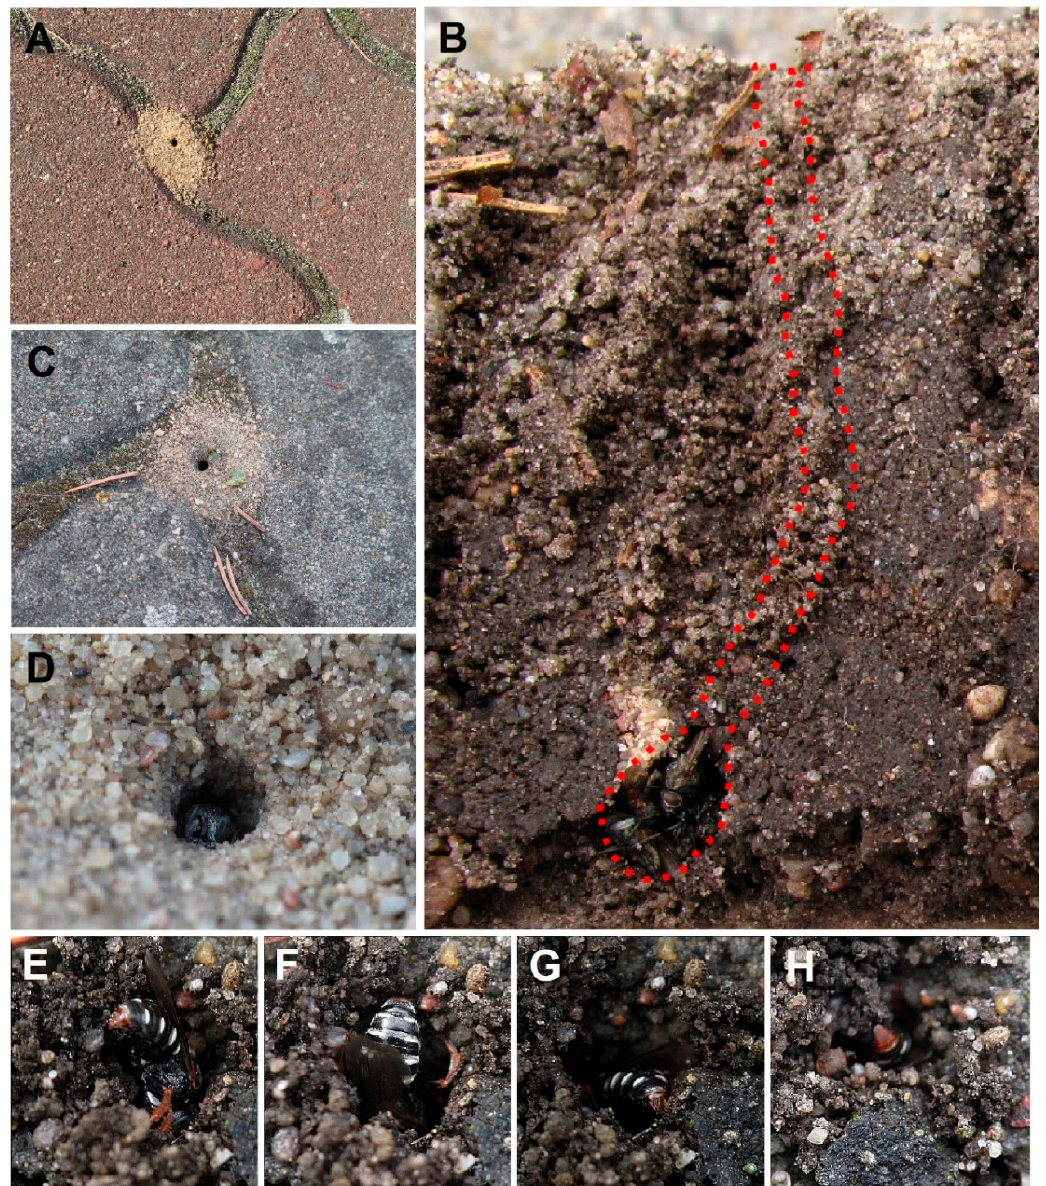
Figure 1. Nest of Oxybelus variegatus . ( A , C , D ) Top view of the nest entrance; ( B ) cross-section of the nest after removing a single paving stone ; ( E – H ) burrow excavation .